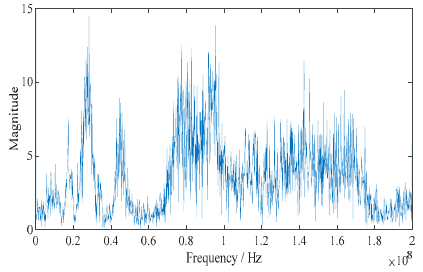
Figure 10. Fourier frequency spectrum of the arc current.